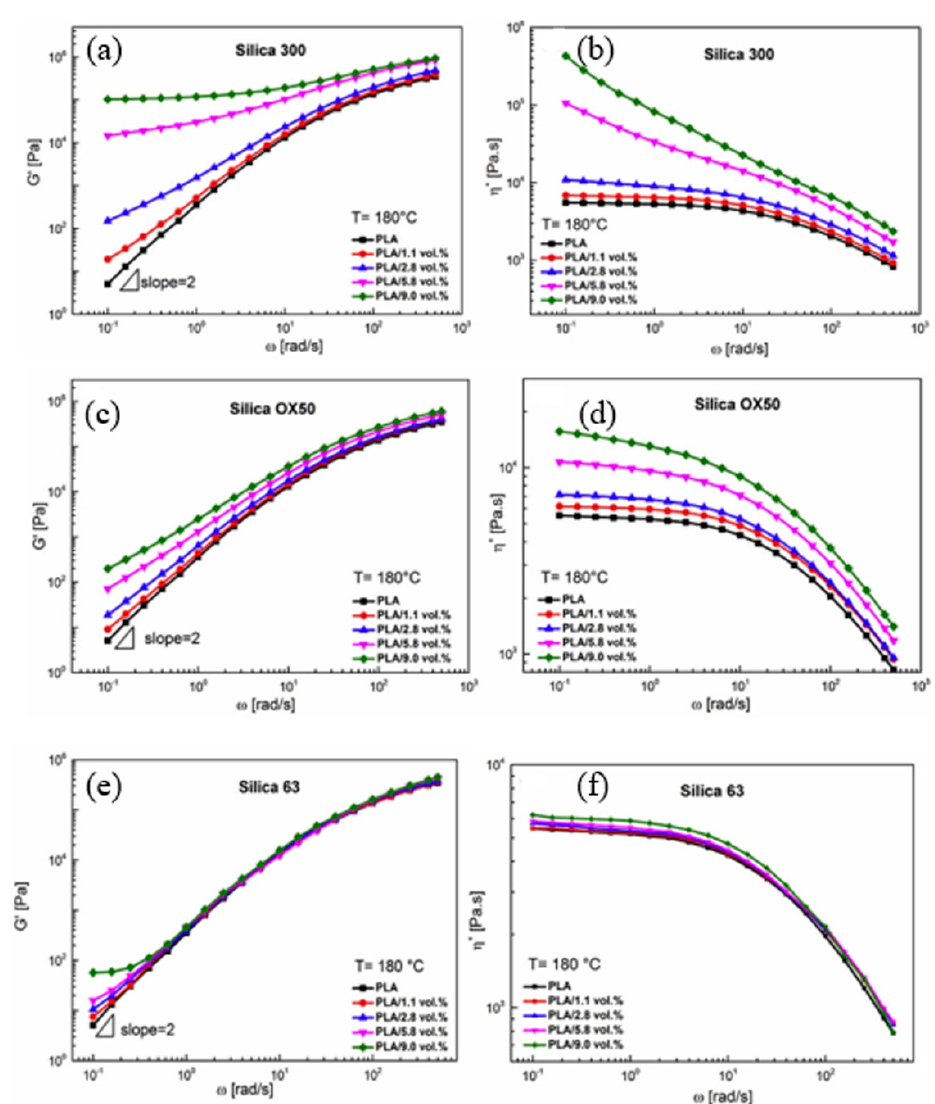
Figure 3. The influence of silica type on the rheological properties of PLA/silica composites: ( a , b ) PLA/silica 300; ( c , d ) PLA/silica OX50; ( e , f ) PLA/silica 63 [54].